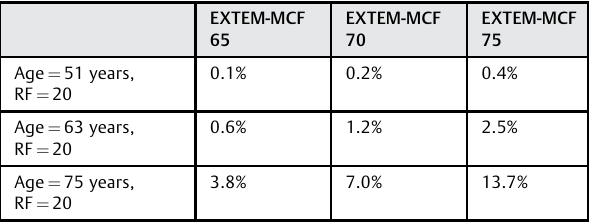
Fig. 1 Predicted probability of death vs risk score. Distribution of patients across range of risk scores, corresponding to the logit (logged odds ratio) calculated using logistical regression with the three predictor variables at inclusion (EXTEM-MCF, age, and respira- tory frequency). Thehistogram in black, presented in thelower partof the fi gure, shows the distribution of risk scores in the present data (e.g., 12 patients have a risk score of 0, translating to approximately 50% probability of dying within 30 days). MCF, maximum clot fi rmness.